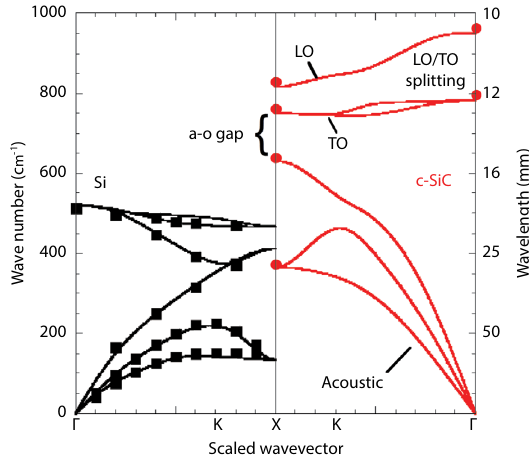
Figure 9 Calculated phonon dispersions in the Γ→ K → X high symmetry direction for Si (black curves) and 3C-SiC (red curves) with experimental data for Si (black squares) [132] and 3C-SiC (red circles) [133]. Polar 3C-SiC has a frequency gap between the acoustic and optic branches ( A-O gap) and a frequency gap between the LO and TO branches ( LO/TO splitting). These features are not present in Si, which has purely covalent bonding and identical unit cell